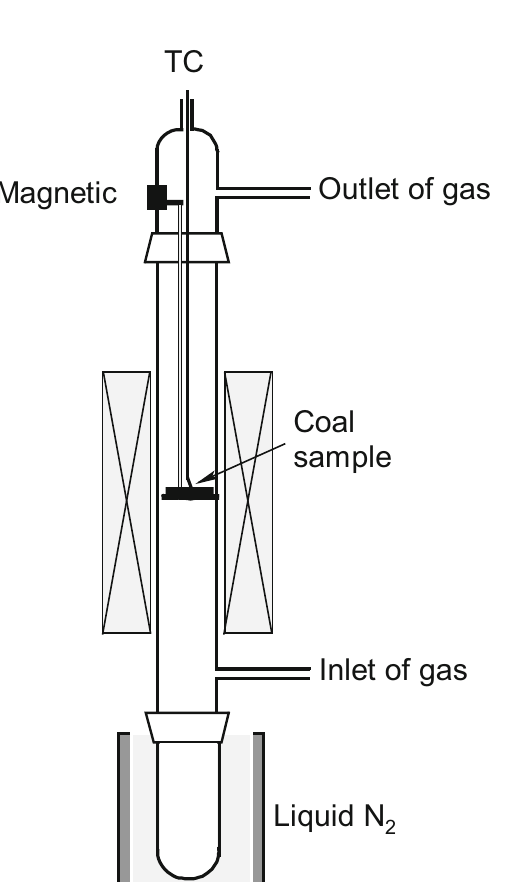
Fig. 1 Apparatus of horizontal tube reactor with quadrupole mass spectrometry